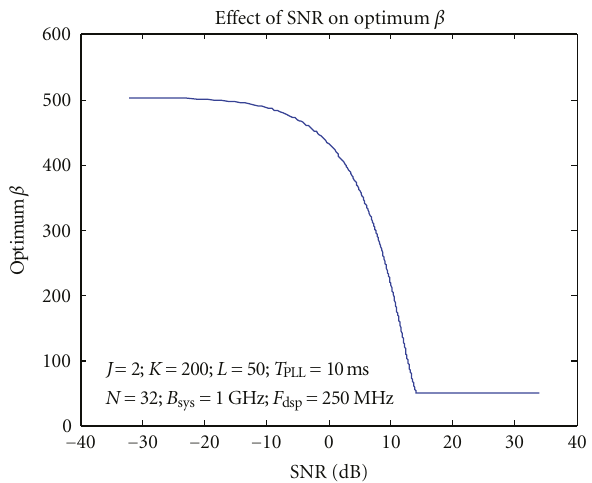
Figure 9: E ff ect of SNR on Choice of Optimal β .